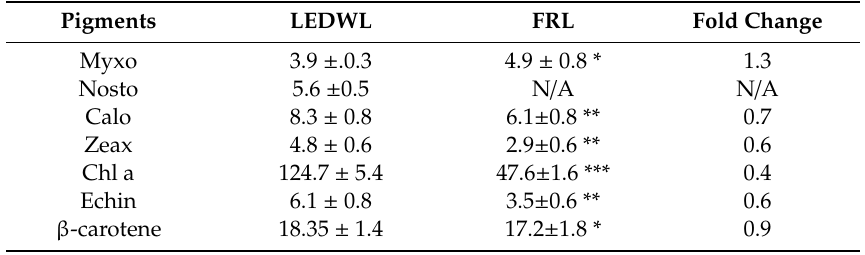
Table 1. Concentration ( µ g g − 1 of dry weight) of main pigments present at day 9 within C. fritschii biomass during LEDWL and FRL conditions, including fold change comparing LEDWL and FRL.